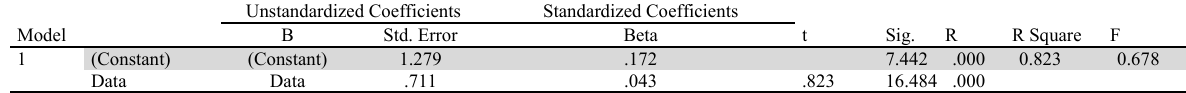
The results of testing the fourth sub-hypothesis Model